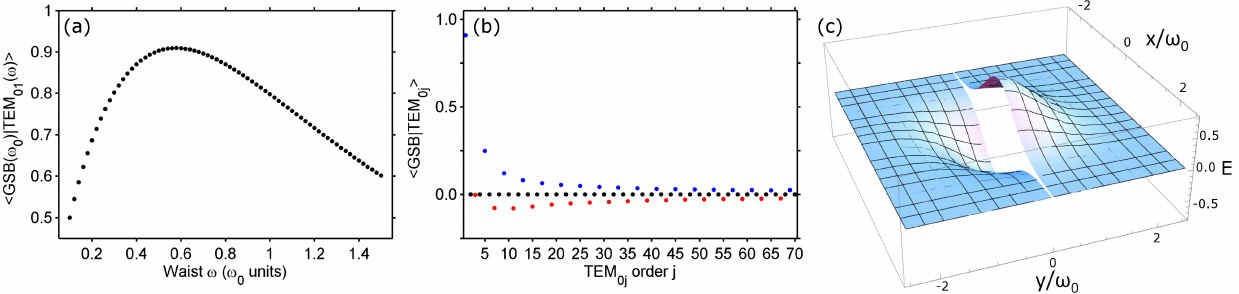
Figure 2. (Color on-line) ( a ) Conversion efficiency from a TEM to a TEM mode with waist ω using a 0- π phase step as a mode convertor. The conversion 01 efficiency is computed as the overlap integral between the Gaussian phase-plate-shaped beam (GSB) and a TEM beam of waist ω . A maximum of 90.94% is reached for ω = 0 . 58 × ω 01 ( b ) Decomposition of the spatial profile of the beam after the phase plate in the TEM Each coefficient is calculated as the overlap integral between the GSB and the TEM of waist 0 . 58 × ω . TEM modes do not contribute. TEM 0 02 i (red dots) modes contribute with opposite signs. ( c ) Three–dimensional view of the GSB electric